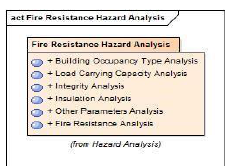
Figure 5: Tasks of fire resistance hazard analysis